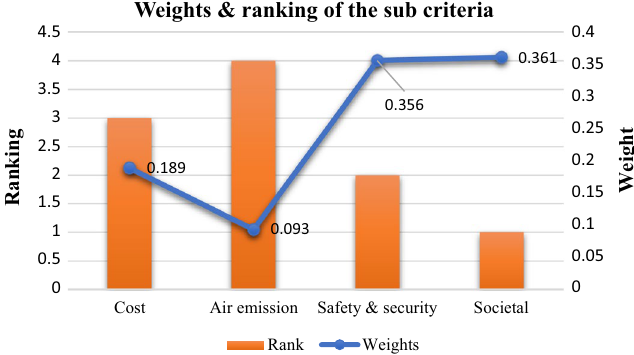
Fig. 9 Weights and ranking of the sub